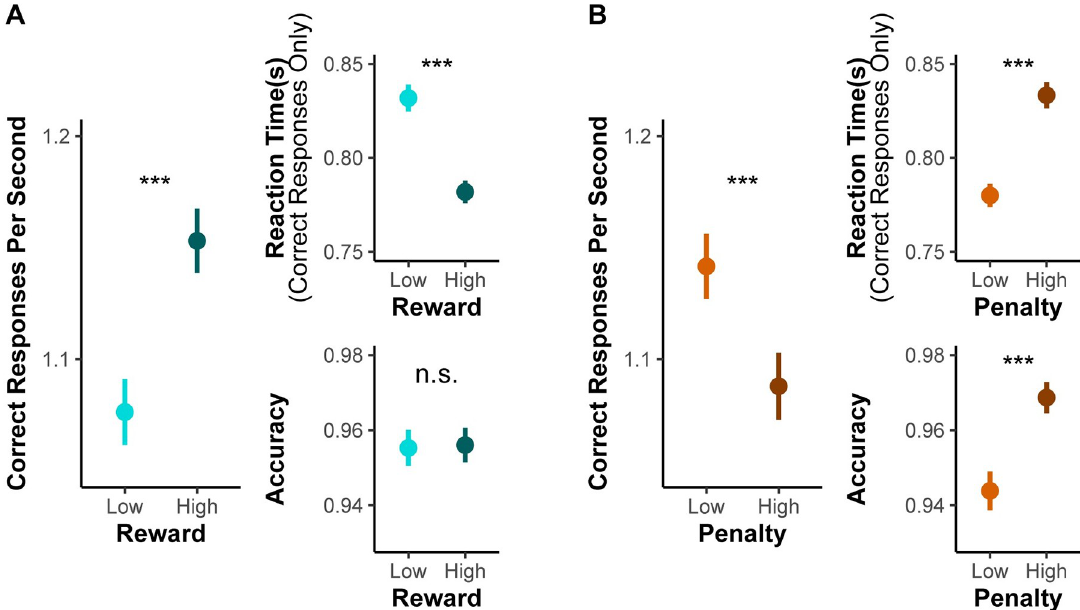
Fig 2. Effects of reward and punishment on overall task performance (Study 1). (A) With increasing expected reward, participants completed more correct responses per second within a given interval ( left ), which reflect faster responding on correct trials ( top right ) without any change in overall accuracy ( bottom right ). (B) With increasing expected punishment, participants instead completed fewer trials per second over an interval, reflecting slower and more accurate responses. Error bars reflect 95% CI. n.s.: p > 0.05; ��� : p < 0.001.